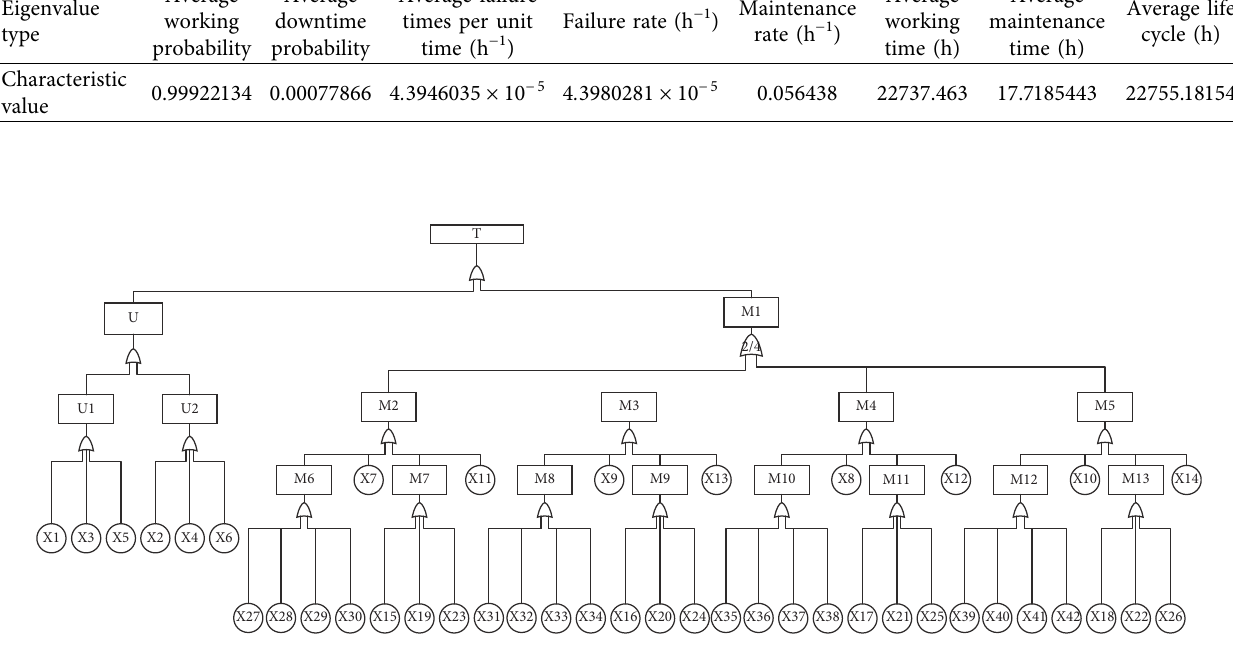
Figure 7: The fault tree model of the MTS.